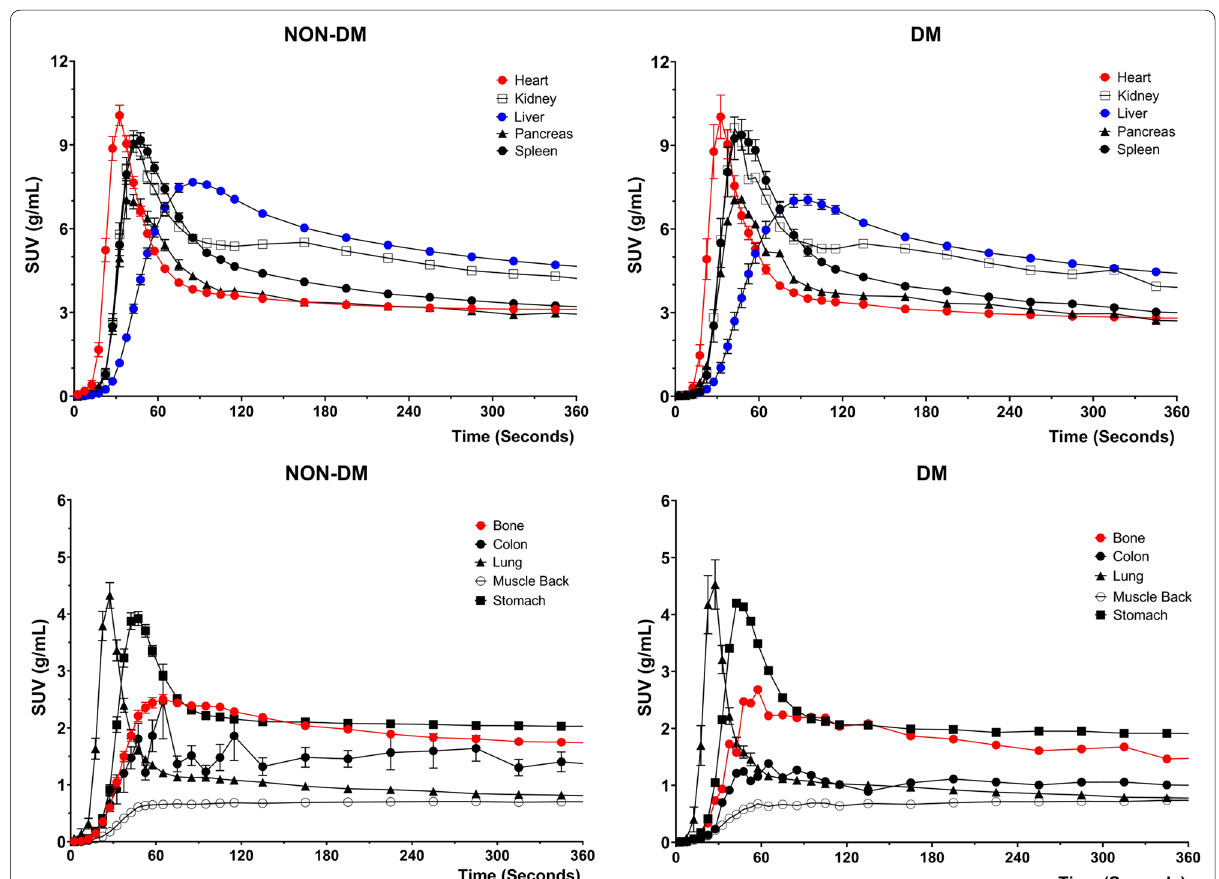
Fig. 3 Time-activity curves for the first 6 min of dynamic scanning over the chest area. Represented values are mean and SEM of all 126 patients. The panels on the left side correspond to the patients without diabetes; the panels on the right side to the patients with